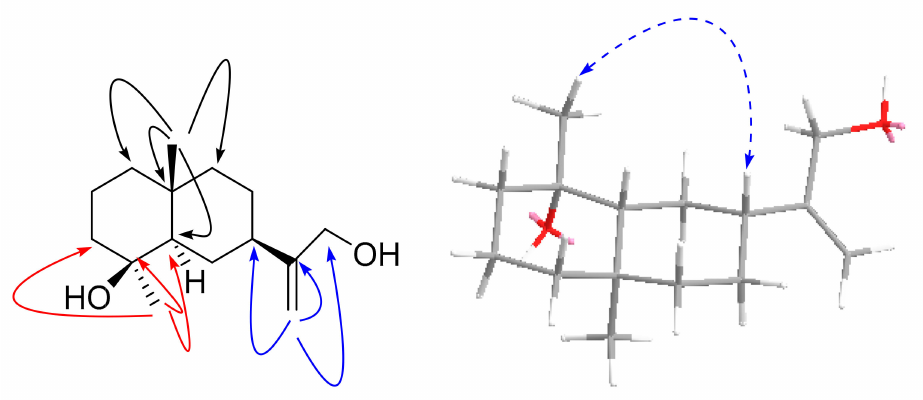
Figure 5. Key HMBC ( → ) and ROESY ( ↔ ) correlations for Compound 2